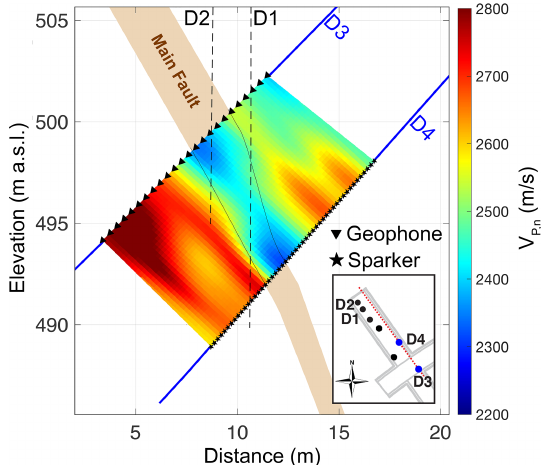
Figure 15. V P tomogram obtained by cross-hole travel-time inver- sion between borehole BCS-D3 (geophones) and BCS-D4 (sparker sources). Locations of geophones and sources are indicated by tri- angle and star symbols,